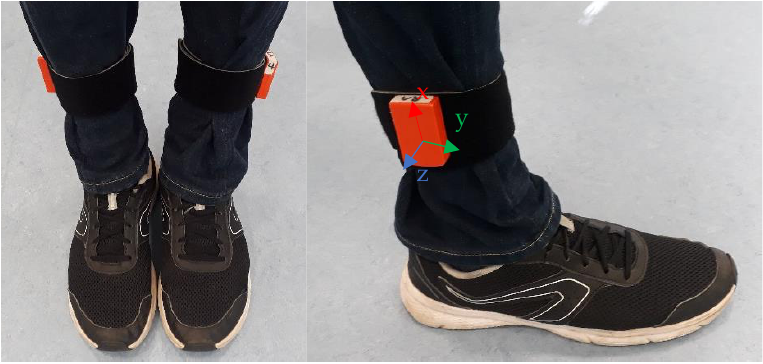
Figure 1. The placement of the sensors on each leg. Primary kinematic parameters, including 3D angular velocity signals (Gyr_X, Gyr_Y, and Gyr_Z) for labeling the gait phases, as well as rotation matrix “Mat [1][1]” (RotMat), also known as Direction Cosine Matrix to detect turning and 3D free acceleration signals (FreeAcc_X, FreeAcc_Y, FreeAcc_Z) to strengthen the gait phase estimation, were gained from XSENS MT-Manger software v4.6 (https://www.xsens.com/software-downloads (accessed on 1 March 2021)).